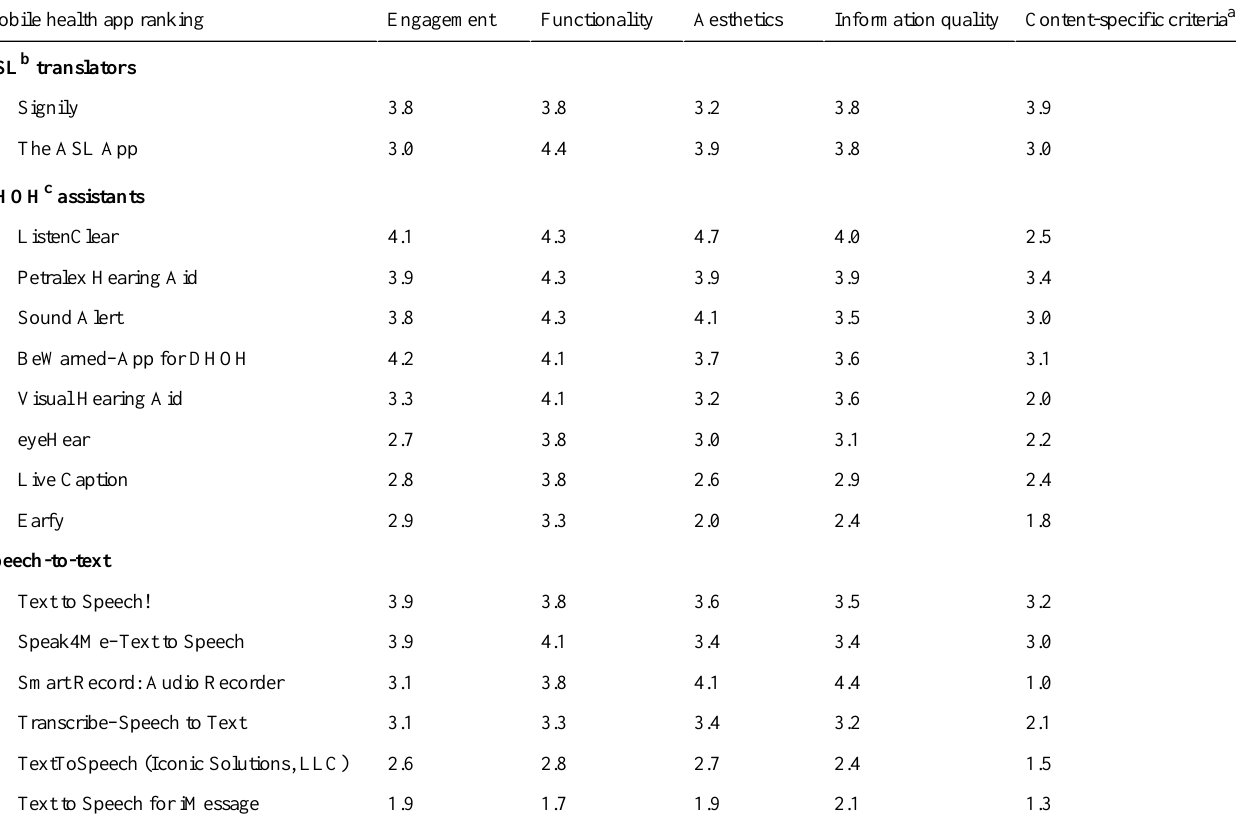
Table 1. Mobile App Rating Scale app quality